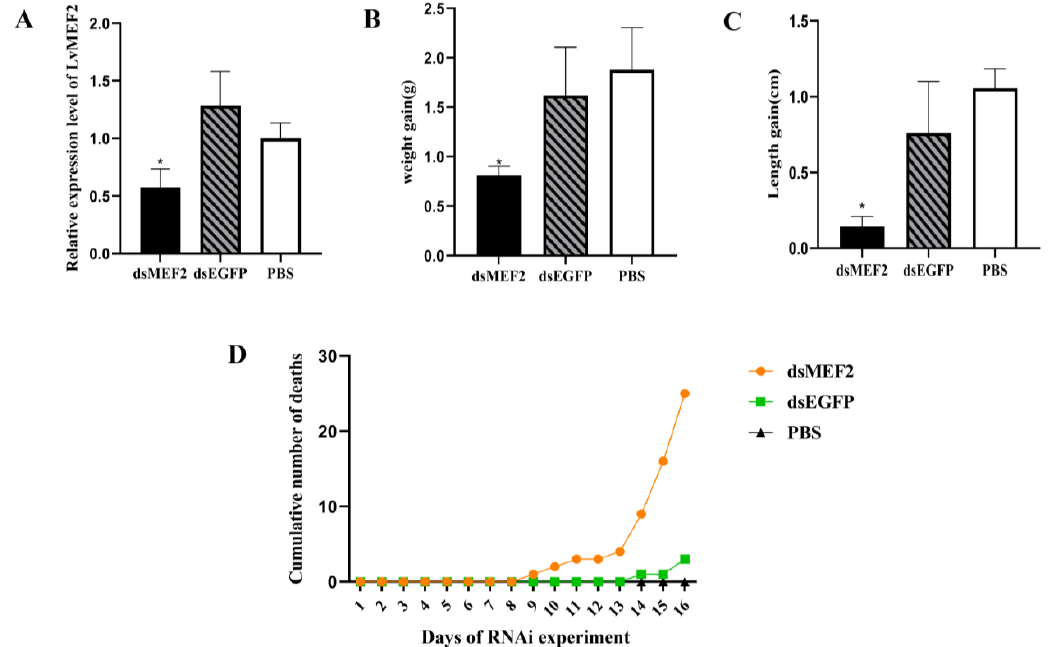
Figure 5. The effects of LvMEF2 RNA interference on L. vannamei . ( A ) Relative expression level of LvMEF2 in muscle after half a month of interference. dsEGFP(Enhanced Green Fluorescent Protein) and PBS were used as controls. The expression of target genes was detected by qRT - PCR, and 18S rRNA gene was simultaneously amplified as the internal reference. ( B ) Changes in shrimp body weight after half a month of RNA interference. ( C ) Changes in body length after half a month of RNA interference. These results were based on three independent biological replications and shown as mean values ± SD. Significant differences in the gene expression levels between three treatments are shown as * p < 0.05. ( D ) Cumulative number of deaths during the LvMEF2 gene in- terference.